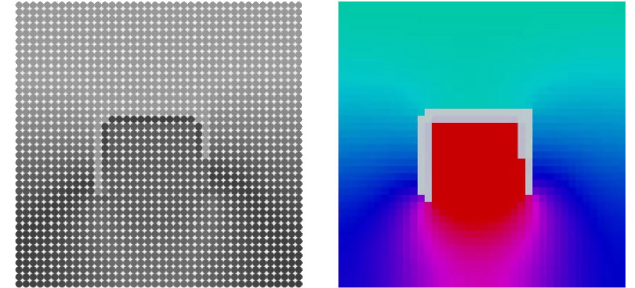
FIG. 5. S3 student started with the left visualization and modified it, in several steps, to end up with the right visualization. This is a recreation of the student ’ s code and may differ in the precise final result, but the transition is the same — going from a black and white representation using circles to a colorful representation using